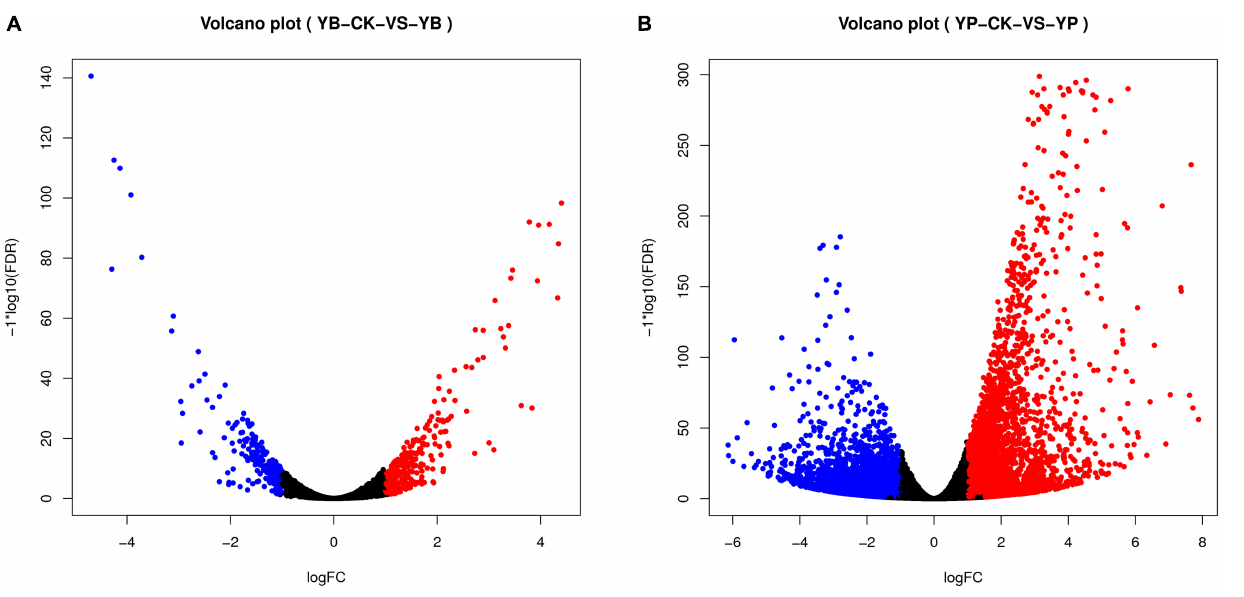
FIGURE 4 | Visualization of differentially expressed genes (DEGs) in the interaction transcriptome (volcano map). DEGs were analyzed using DESeq2 (V1.6.3) in the Bioconductor software package and mapped to volcanoes. Red dots indicate gene up-regulation. Blue dots indicate gene down-regulation. The abscissa represents the fold change in gene expression in different samples. The ordinate represents the statistical significance of the difference in gene expression. (A) Visualization map of DEGs in strain YC0136. YC0136 cells in the YC0136-tobacco co-cultured group were labeled YB. YC0136 cells in the control group were labeled YB-CK. (B) Visualization map of DEGs in tobacco. Tobacco roots from the co-cultured group were labeled YP, and tobacco roots from the control group were labeled YP-CK.